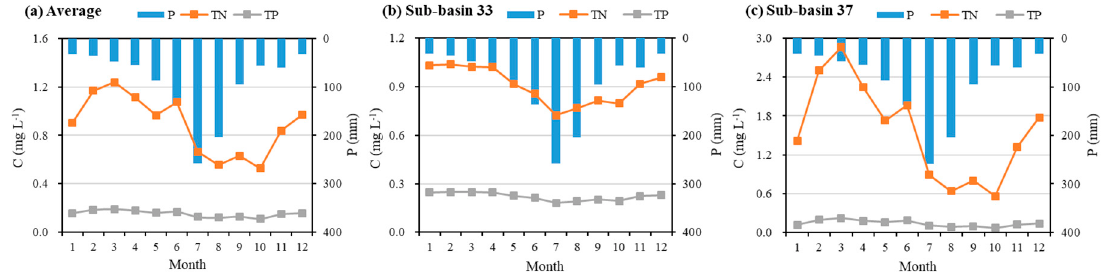
Figure 11. Monthly average concentrations of the NPS TN and TP emissions into rivers during 2000- 2018.